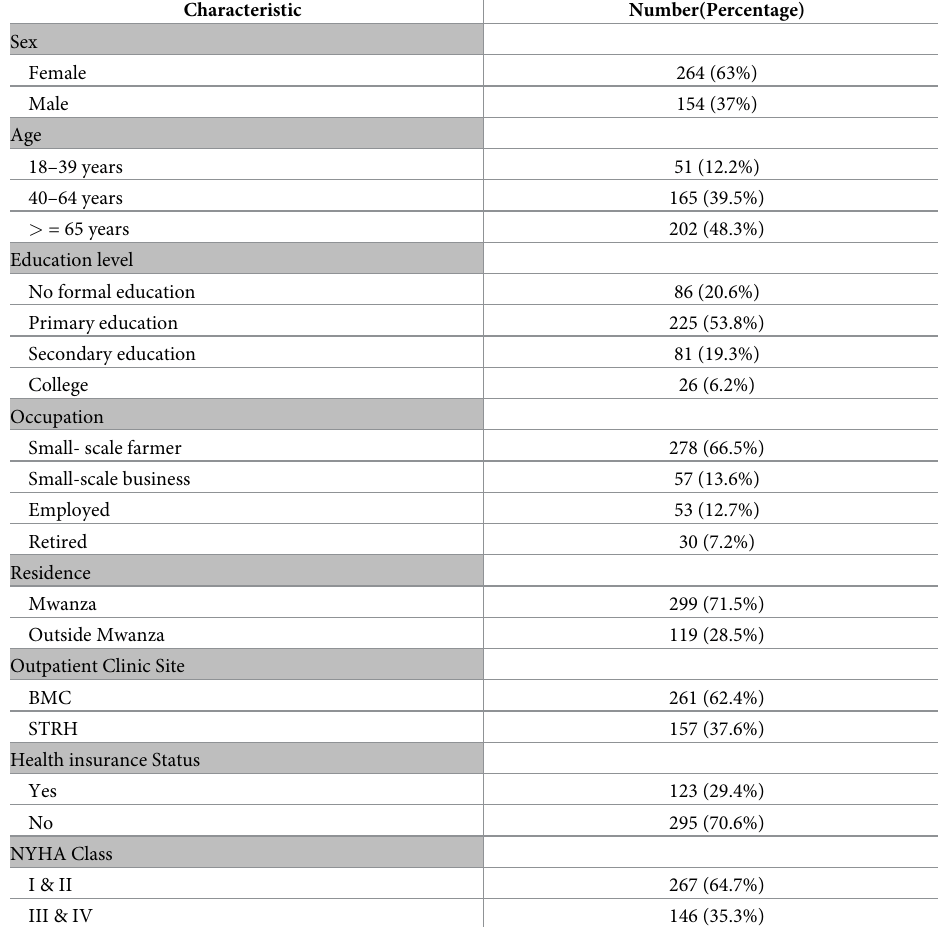
Table 1. Demographic characteristics of 418 heart failure patients at BMC and STRH outpatient clinic in Mwanza, Tanzania.